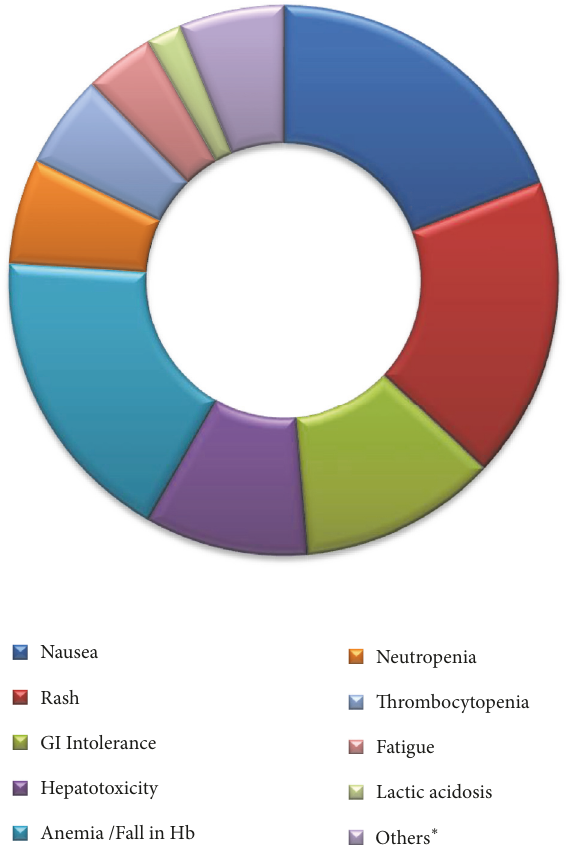
Figure 1: Adverse drug reactions observed. ∗ Others include dyslipidemia, peripheral neuropathy, headache with insomnia, nephrotoxicity, pancreatitis, and